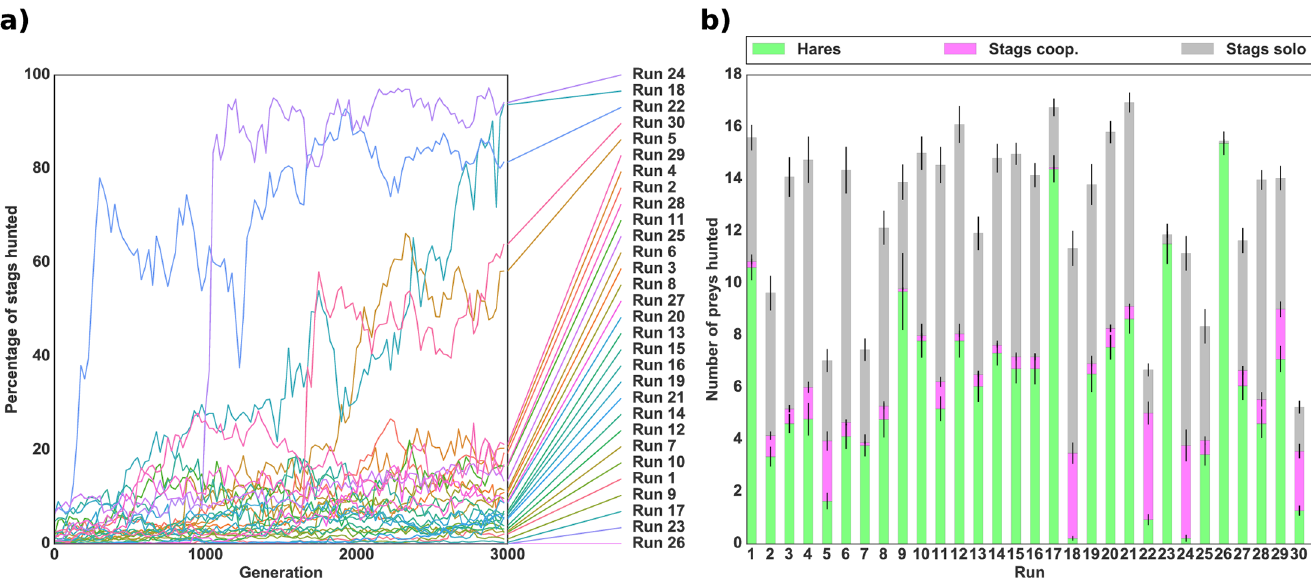
Fig 6. Evolution of cooperation with an initial hare-hunting strategy and a reward for solitary stag hunting. (a) Evolution of the mean percentage of stags hunted successfully (i.e. cooperatively) with respect to the total number of prey hunted in a robotic simulation. (b) Mean number of prey hunted during the last generation of evolution for each independent run. The bottom green bar represents the number of hares hunted, the middle pink bar the number of stags hunted cooperatively and the top grey bar the number of stags hunted alone. The standard deviation for each quantity is shown by black lines. The population for each of the 30 independent runs was previously evolved in an environment with only hares. Rewards were 50 for a hare, 50 for a stag hunted alone, and 500 for a stag hunted cooperatively as presented in Table 3. The number of prey (18) was kept constant throughout the simulation by replacing killed prey by a prey of the same